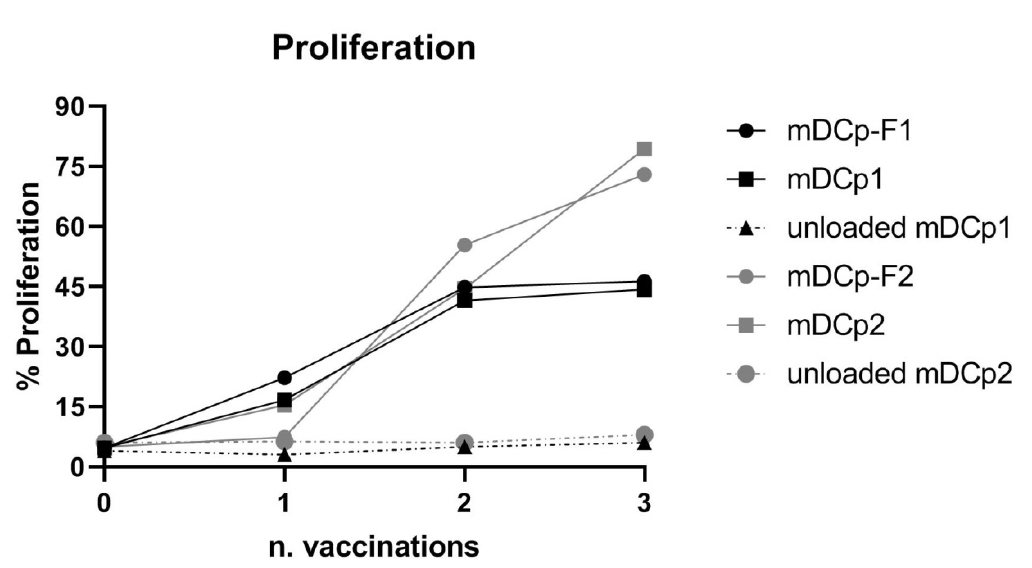
Figure 5. Antigen specific proliferation. Keyhole limpet hemocyanin (KLH)-loaded Fast-DC and KLH-loaded standard method DC induce Ag-specific proliferation of autologous peripheral blood mononuclear cells (PBMCs) isolated from DC-vaccinated patients. Unloaded Fast and standard DC were used as control for aspecific proliferation. The graph represent the proliferation of PBMCs, from two different patients, obtained during 3 sequential DC administrations. Baseline is represented by proliferation measured pre-vaccination (n = 0).